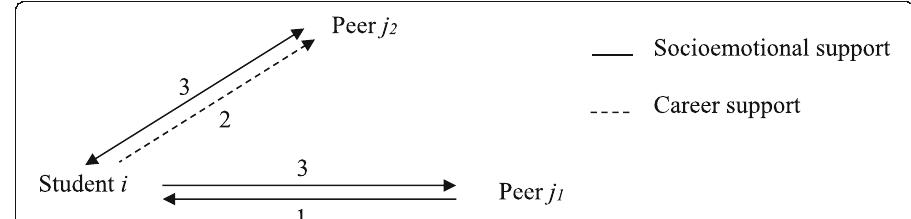
Fig. 1 Exemplary network of fictional student i , reduced to two peers and two network layers, numbers represent tie